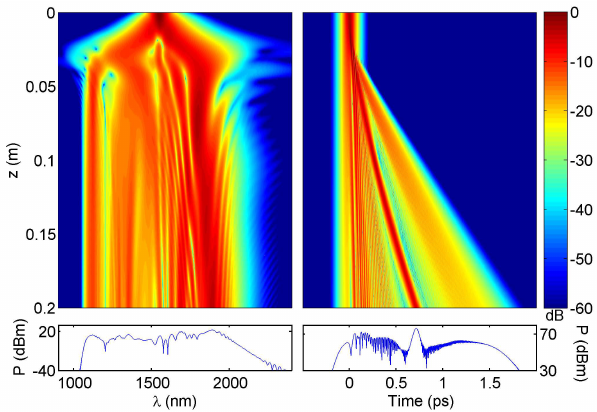
Figure 11: Typical spectrum and waveform evolutions in SC genera- tion. A 50 fs pulse with 80 kW peak power is injected into a 20 cm nonlinear fiber with a ZDW near 1500